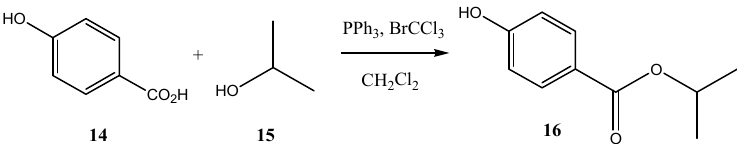
Figure 9. Preparation of 4-hydroxybenzoate ( 16 ) by Appel-type esterification using BrCCl 3 -PPh